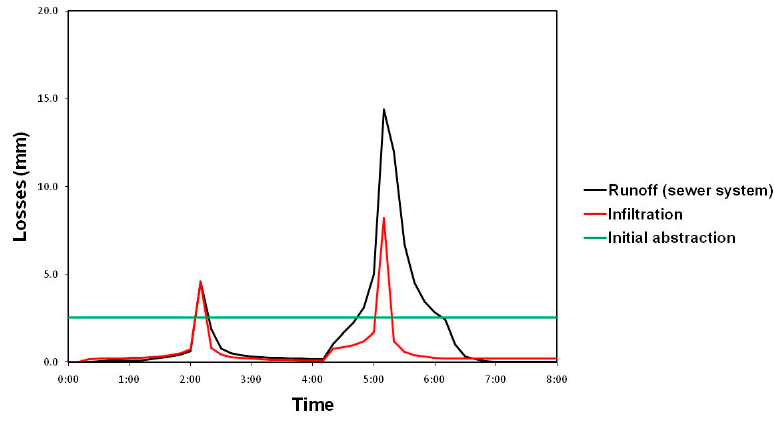
Figure 4. Predicted losses by SWMM software.